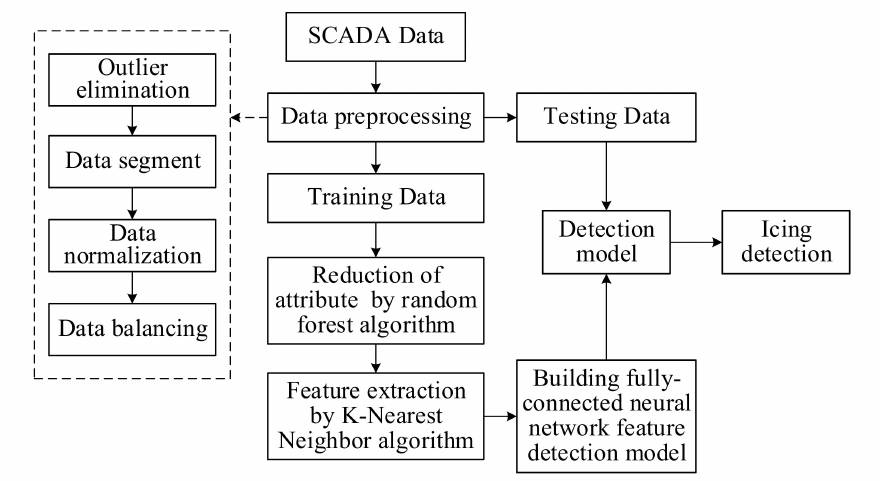
Figure 5. Overview of the proposed icing detection